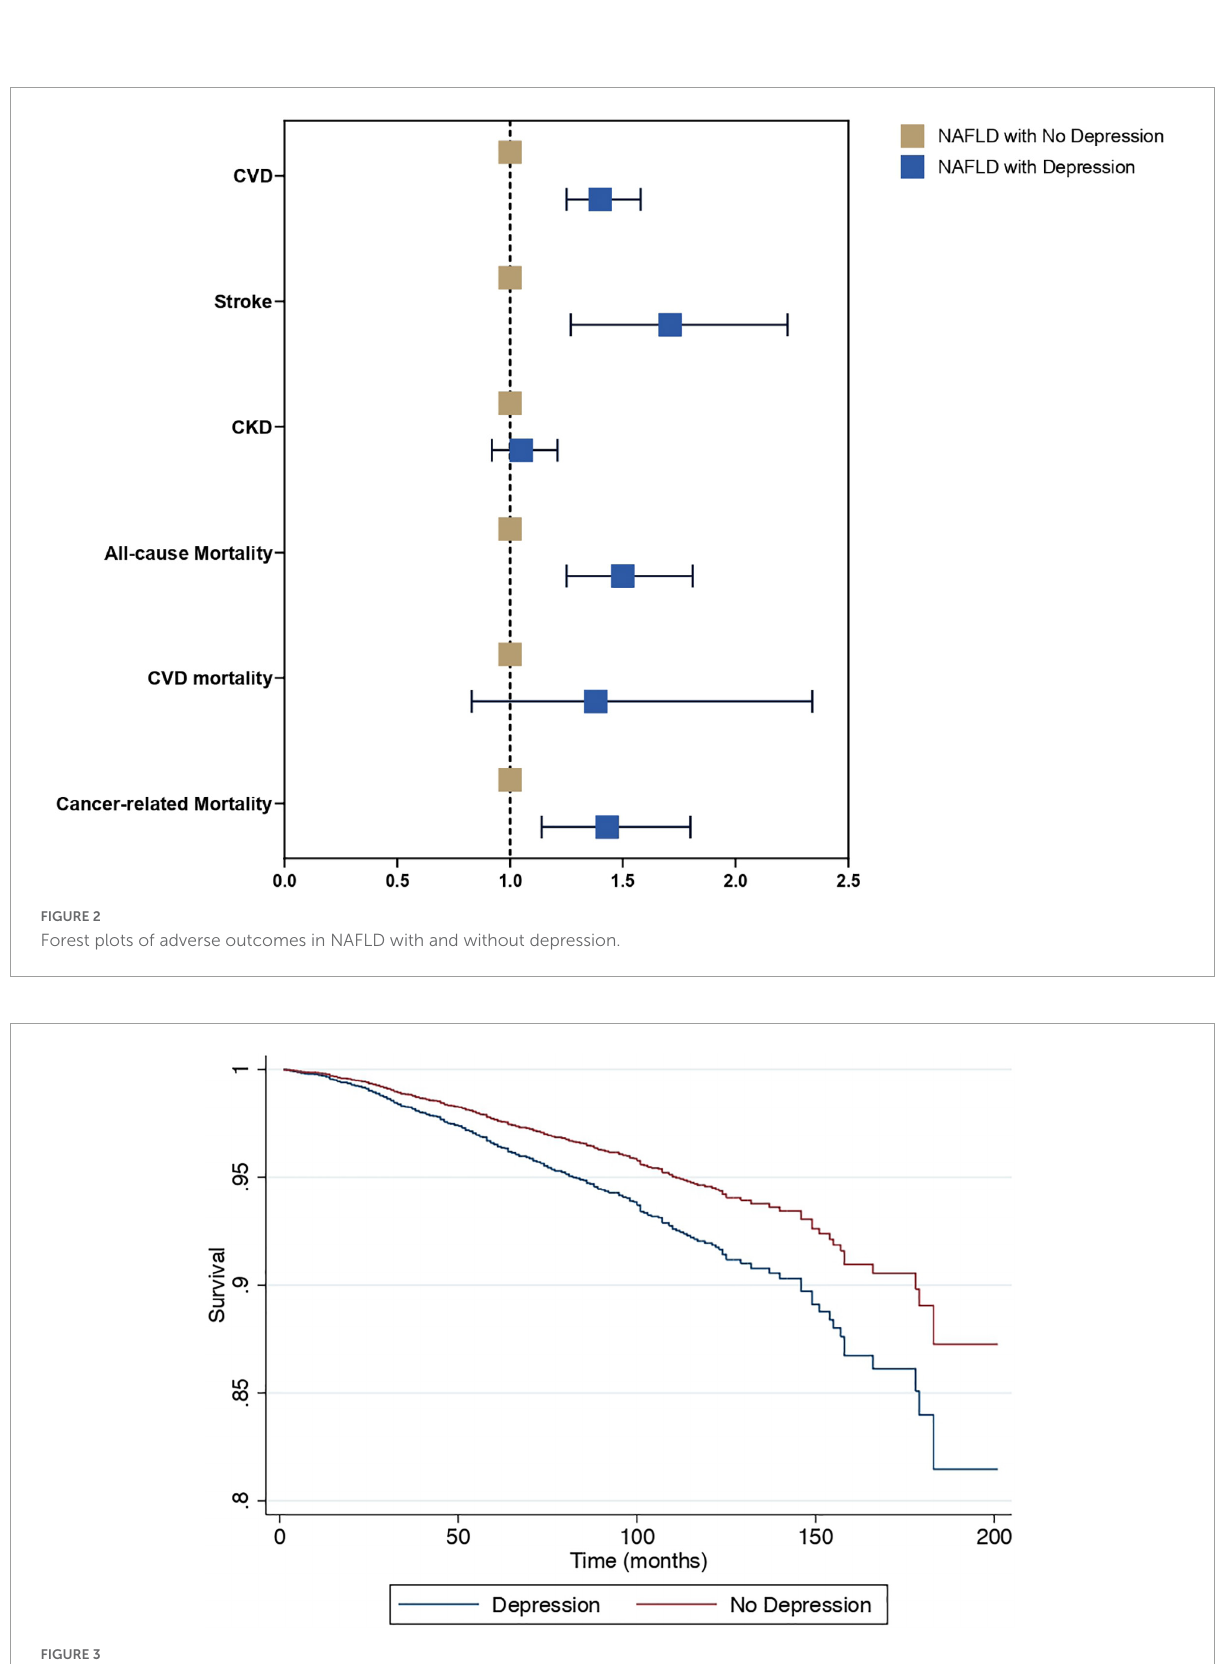
FIGURE3 Cox proportional survival of all-cause mortality with and without